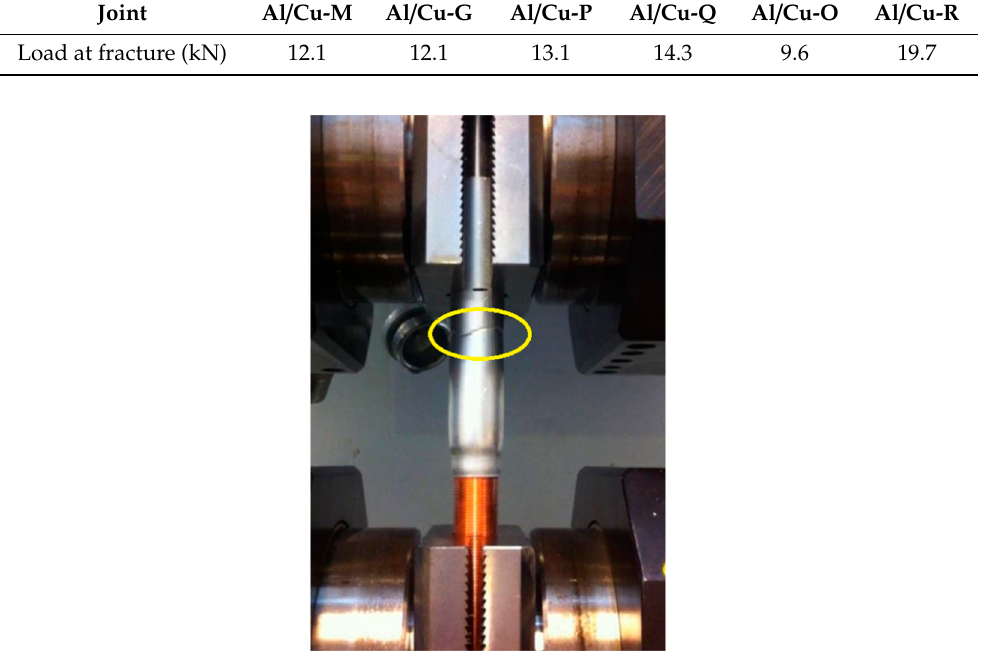
Figure 6. The Al/Cu-R tensile specimen illustrating the fractured zone (seen in yellow